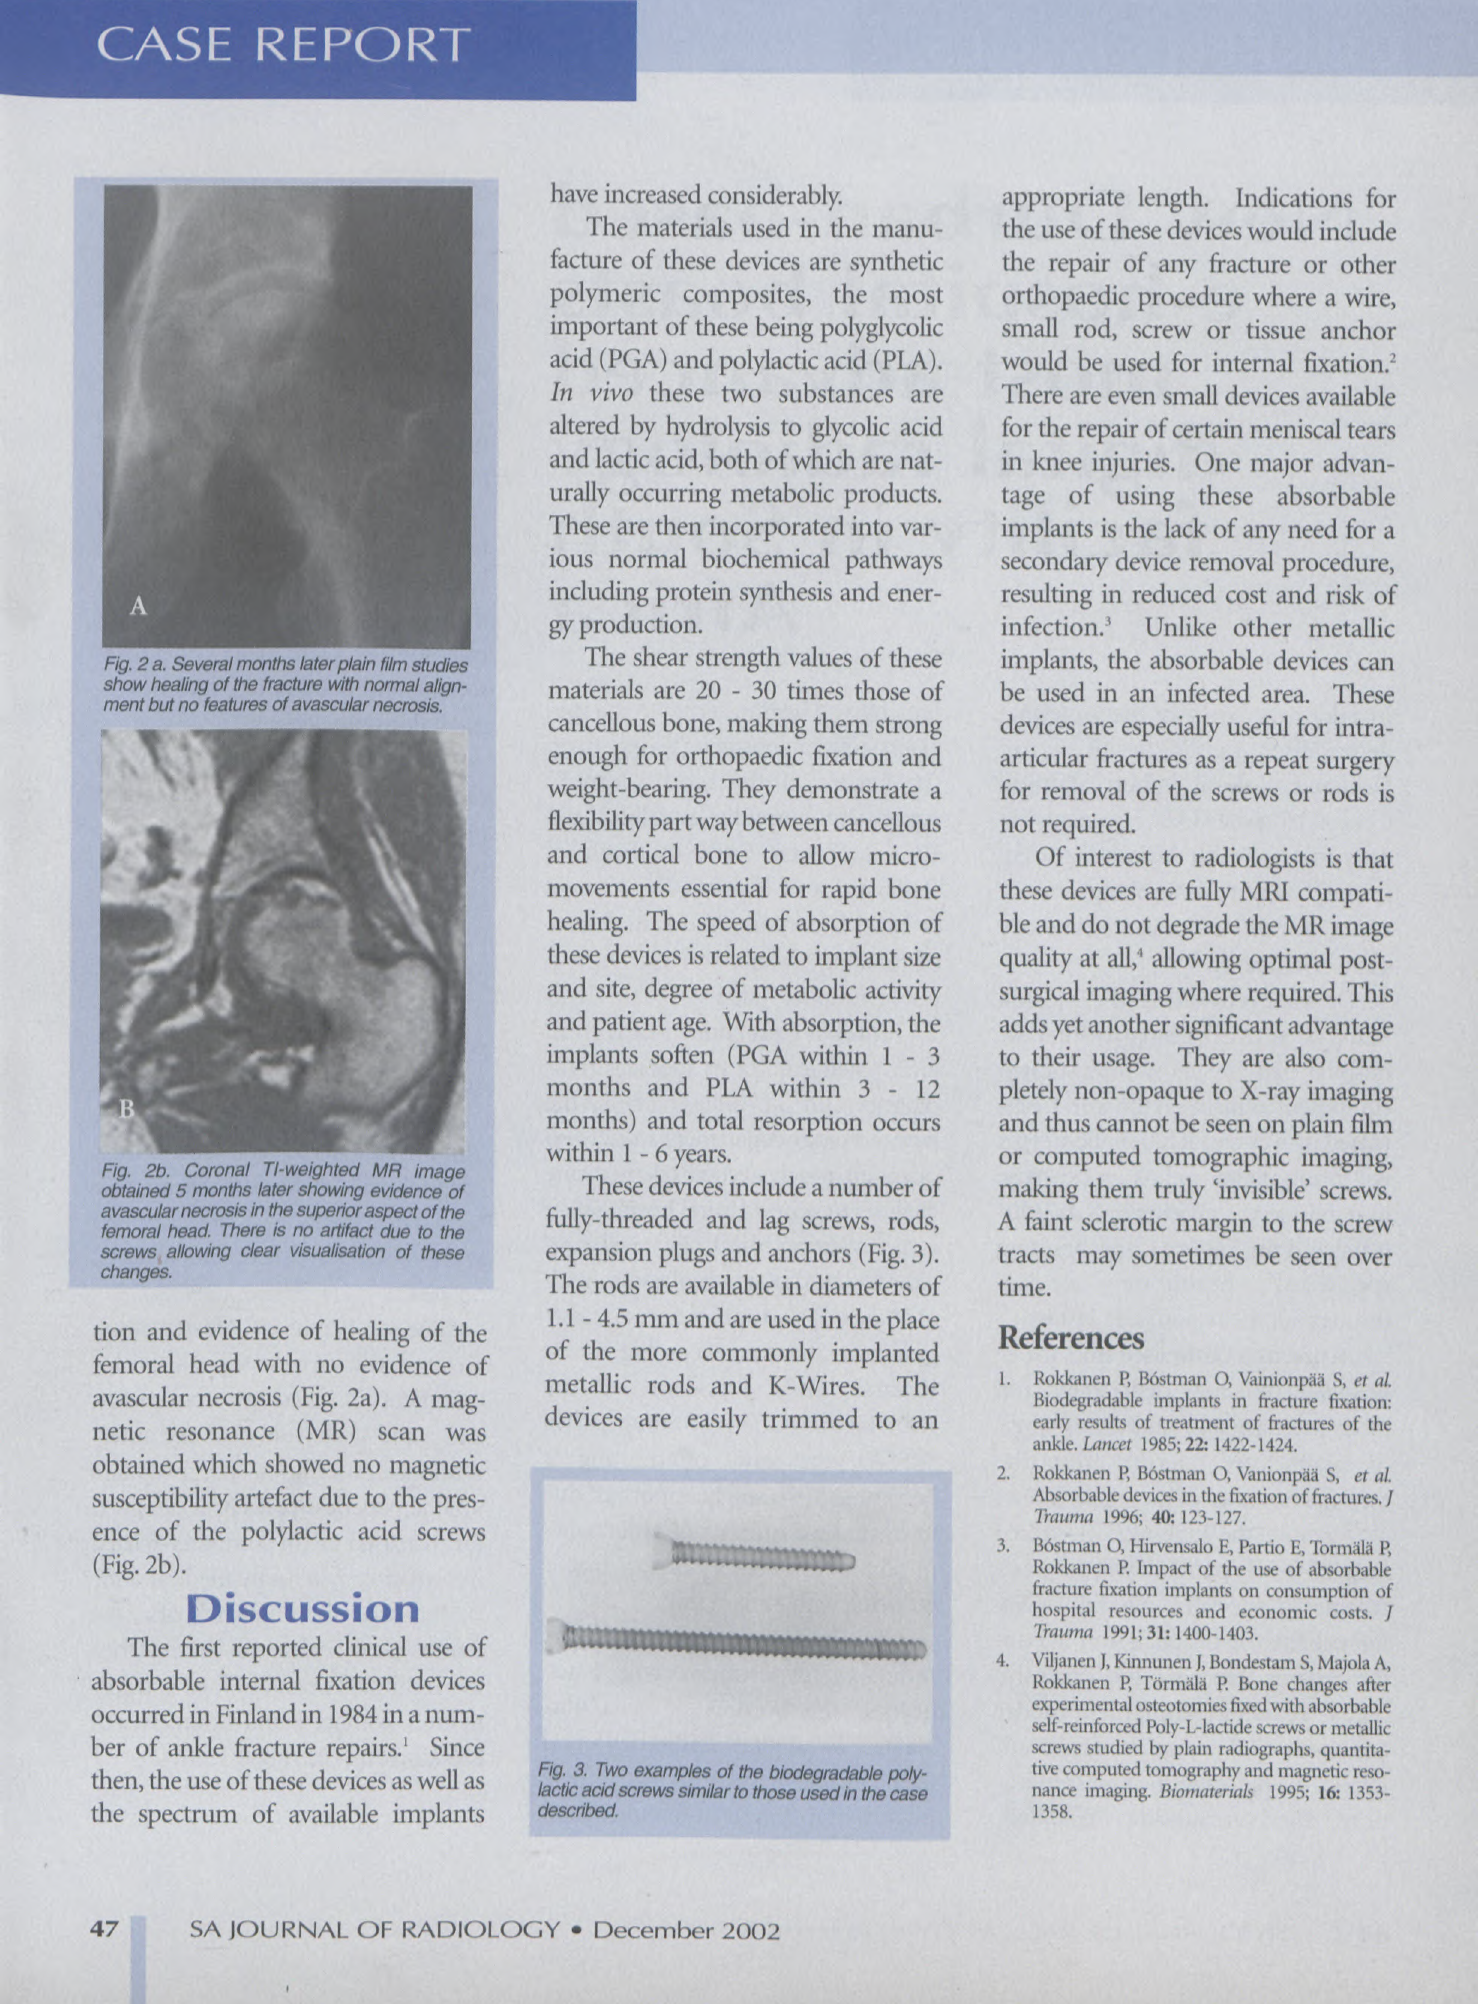
Fig. 2 a. Several months later plain film studies show healing of the fracture with normal align- ment but no features of avascular necrosis.